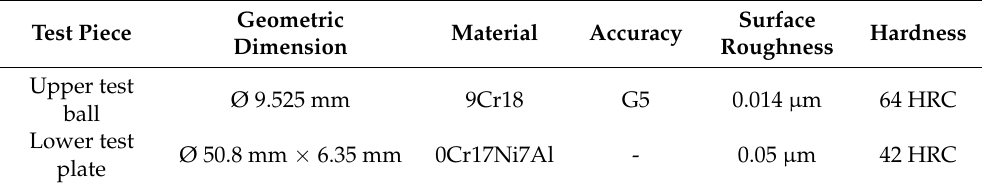
Figure 3. MFT-5000 friction test bench. Table 3. Parameters of the test sample.